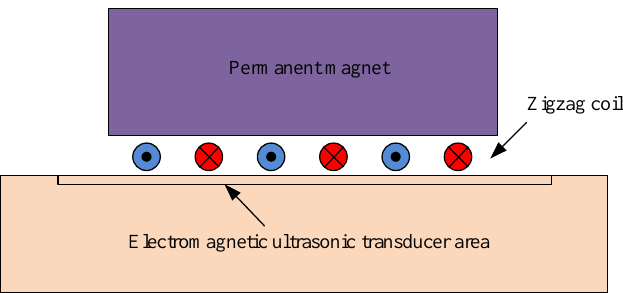
Figure 3. Enlarged view of the EMAT module.